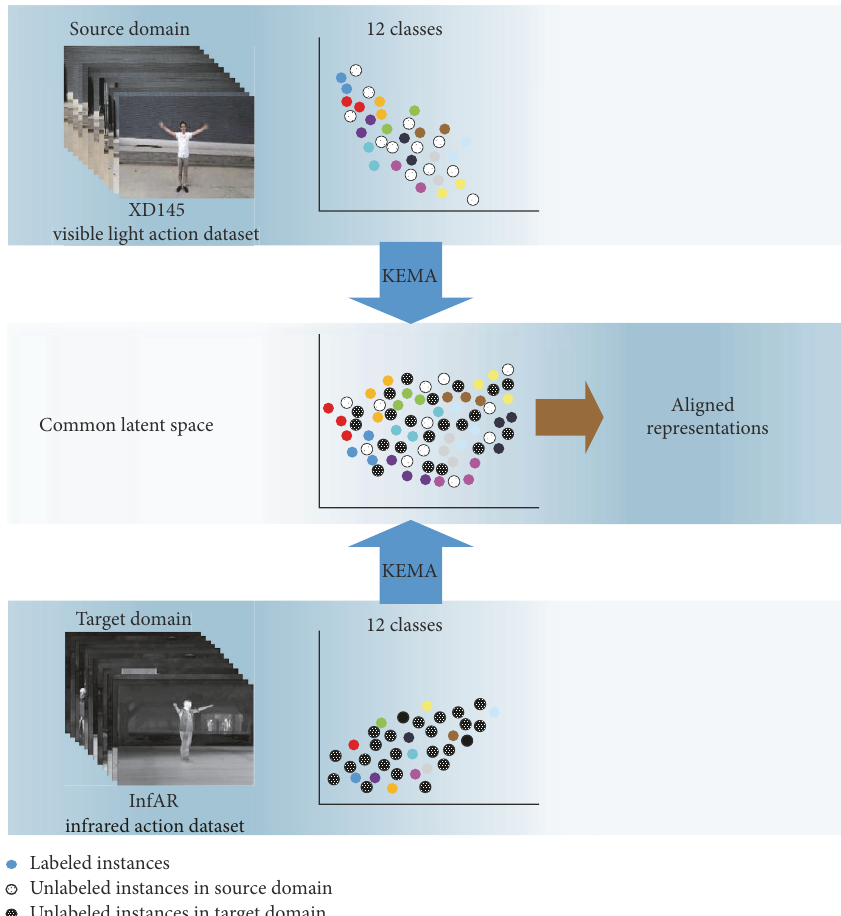
Figure 2: Illustration of feature alignment in a visible-to-infrared action recognition setting. Circles in different colors represent different action